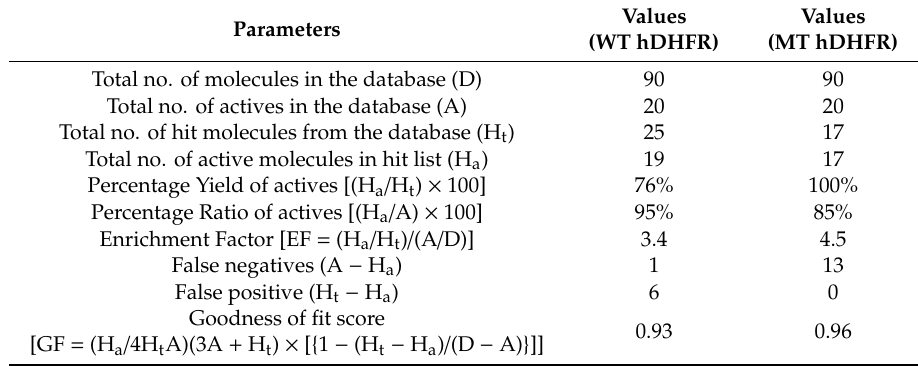
Table 2. Decoy set validation for WT & MT hDHFR structure-based pharmacophore models. WT-pharma and MT-pharma obtained the highest goodness of fit score suggesting the suitability of the models for virtual